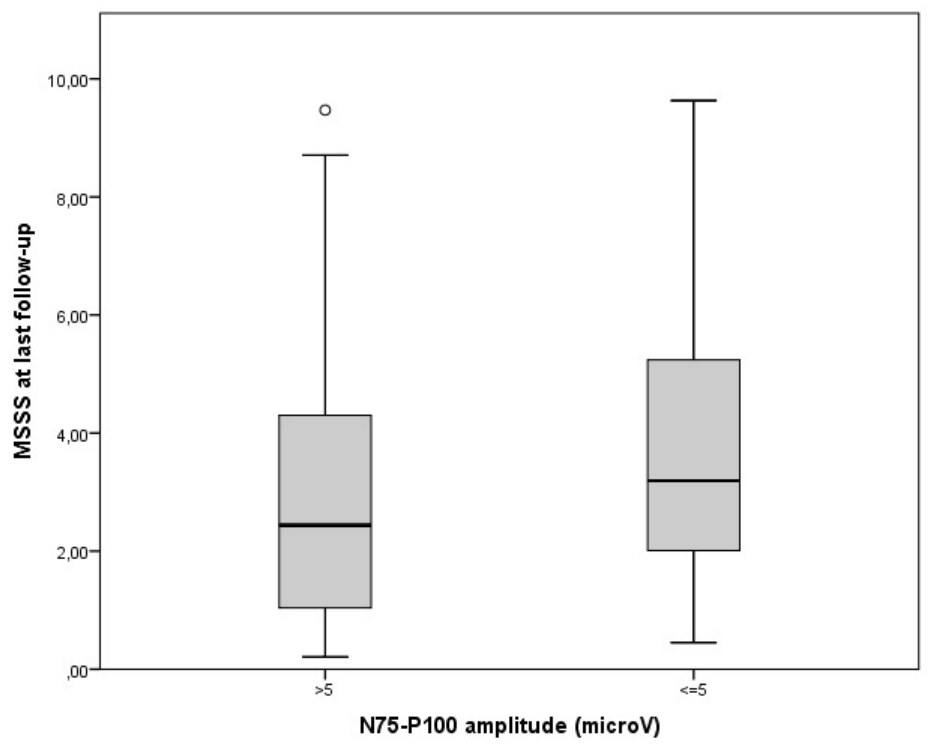
Figure 2. Disability at last follow-up according to baseline N75-P100 amplitude in non-neuritic eyes ( p = 0.009).